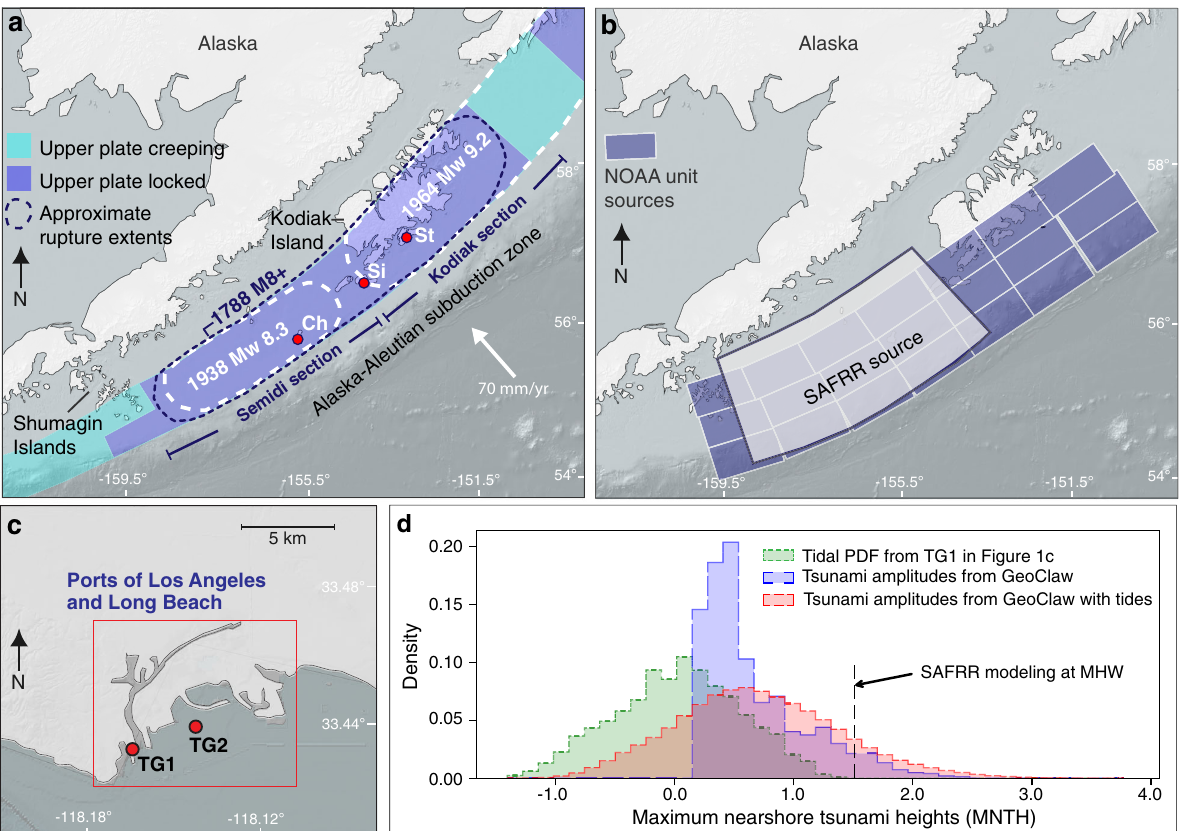
Fig. 1 Alaska-Aleutian subduction zone tectonic setting and distant-source tsunami modeling. a Plate tectonic setting of Alaska showing the locked and creeping sections of the Alaska-Aleutian subduction zone, earthquake section boundaries, and approximate historical earthquake extents. Red circles show sites with paleoseismic evidence supporting multi-section earthquake ruptures. Ch Chirikof Island, Si Sitkinak Island, St Sitkalidak Island. b Light gray shaded area shows the approximate extent of slip used in the U.S. Geological Survey (USGS) Science Application for Risk Reduction (SAFRR) scenario magnitude 9.1 Semidi section earthquake underlain by a grid of the NOAA unit sources used in this paper. c Map of the Ports of Los Angeles and Long Beach showing the location of the long-term tide gauge (est. 1923) measuring water levels at the ports (TG1 67 ) and the synthetic tide gauge (TG2) where maximum nearshore tsunami heights (MNTH) were measured in this study. d Plot showing the probability density function (PDF) of the MNTH from our suite of modeled earthquake magnitudes in the year 2000 with no tidal variability included (blue histogram), the PDF of the tidal variability at TG1 (green histogram), and the combined MNTH and tidal variability PDF (red histogram). The dashed line shows the 1-m amplitude SAFRR scenario tsunami striking at high tide (MHW) 16 , resulting in a MNTH of 1.5 m at the